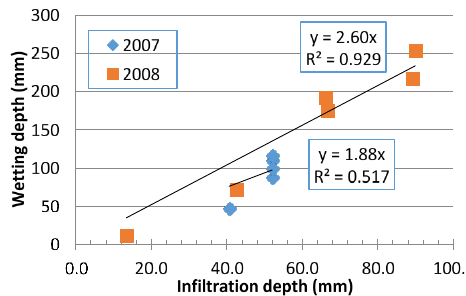
Figure 2. RS (rainfall simulation) plot infiltrated vs. visible wetting depths at Heavenly LT site (granitic